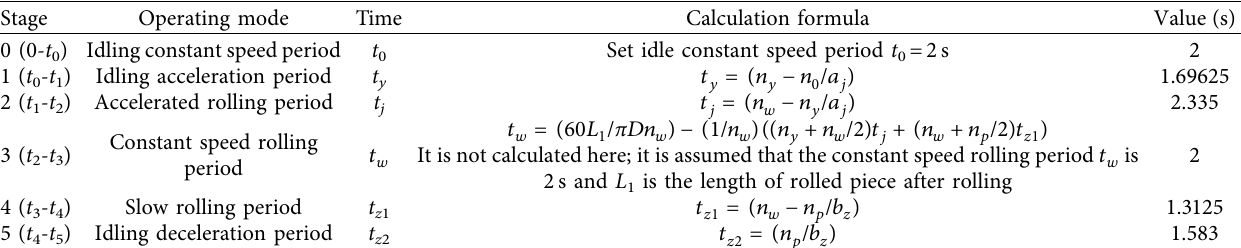
Table 5: Time of each stage of one pass of the reversible rolling mills